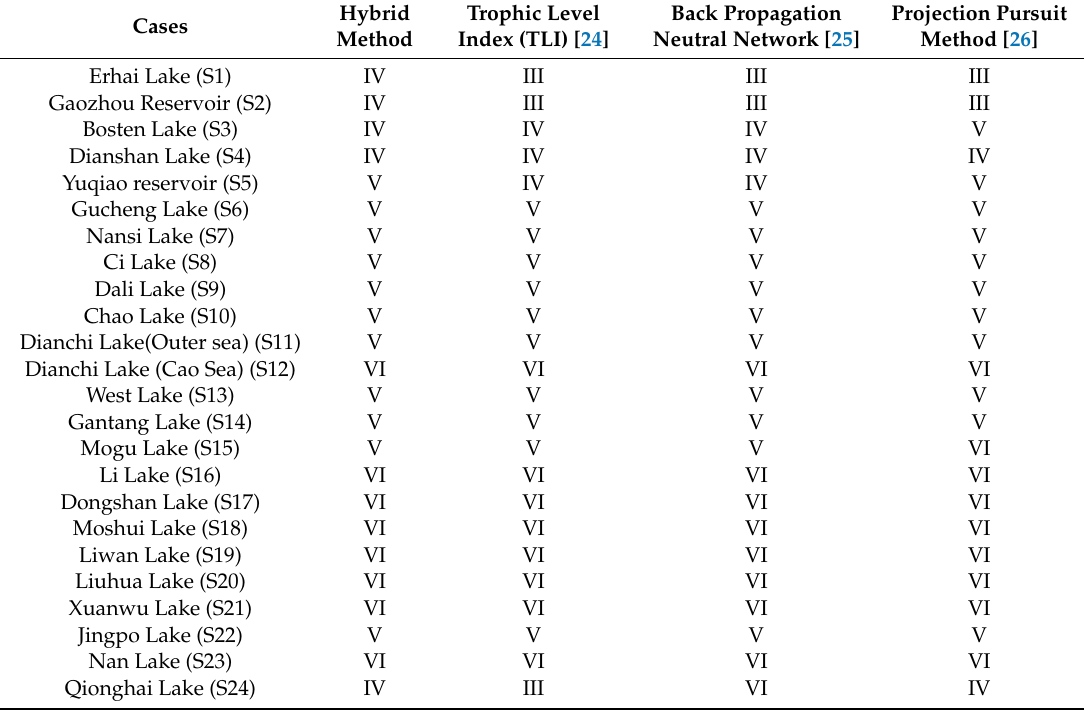
Table 9. Comparison of eutrophication grade between the proposed TFN–MC–FME model and the other relevant